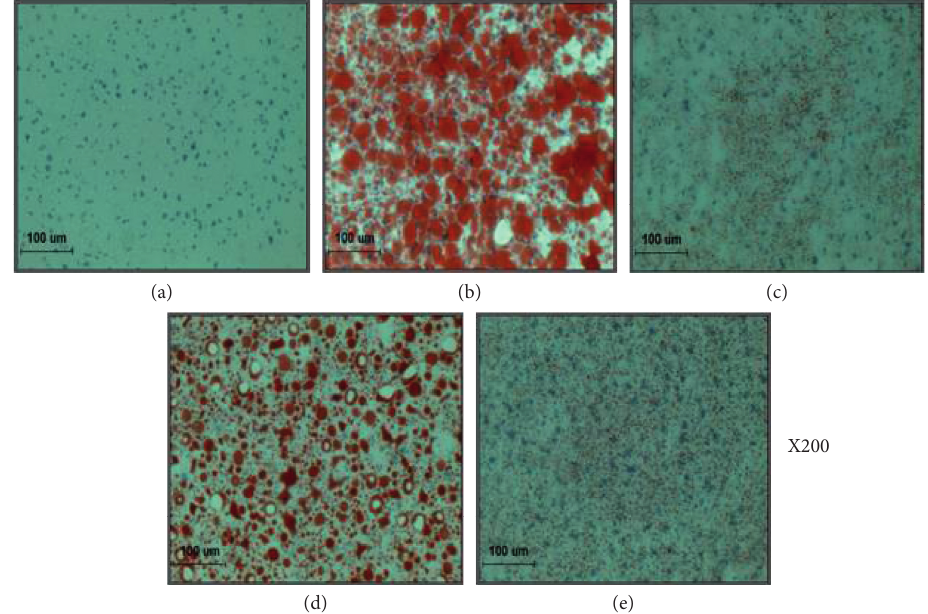
Figure 1: Oil red O staining of hepatic tissue: (a) normal mice, (b) HFD control mice, (c) orlistat 60mg/kg-treated and obese mice, (d) PCM 50mg/kg-treated and obese mice, and (e) PCM 100 mg/kg-treated and obese mice ( ×